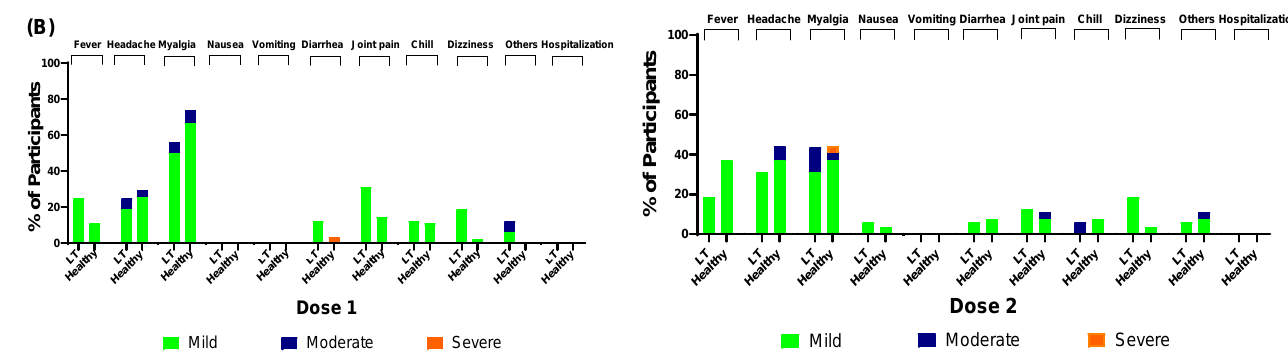
Figure 5. Adverse events during the 7 days after the first and second doses of BNT162b2 administra- tion. ( A ) Local adverse events; ( B ) systemic adverse